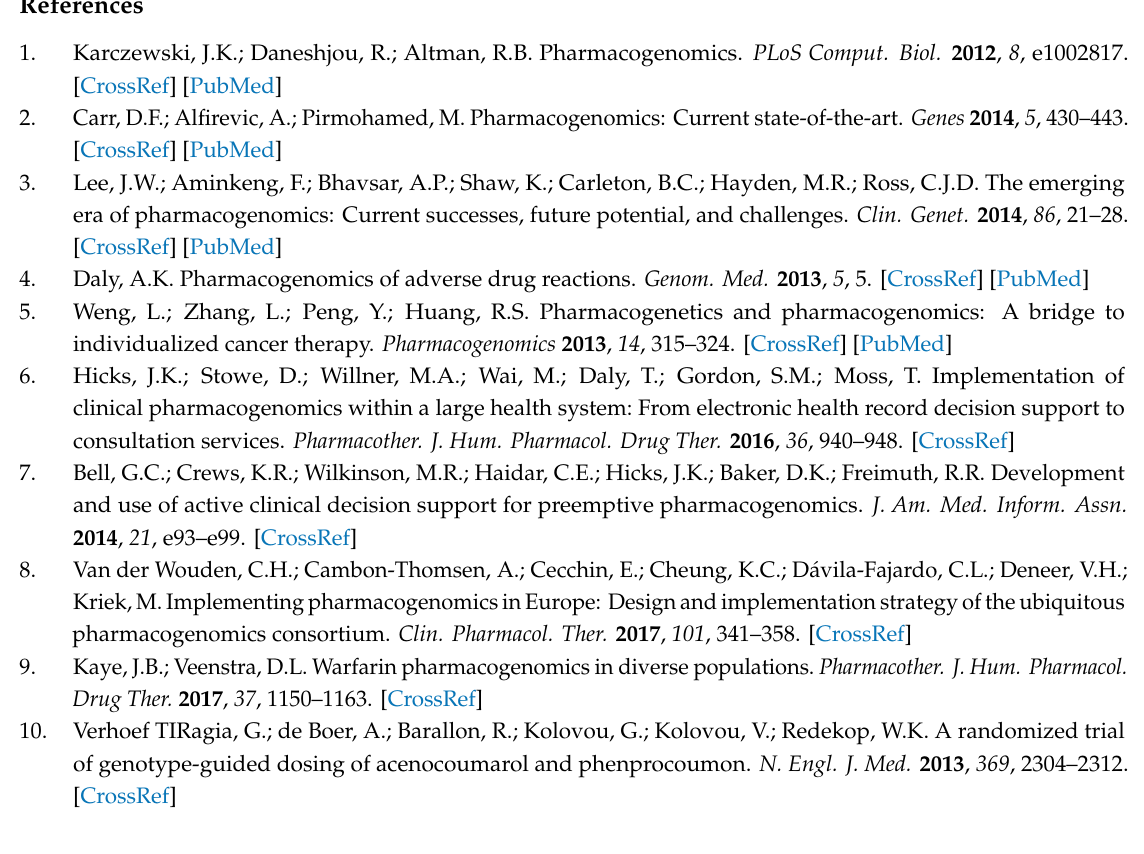
Figure S1: The number of SNPs in each biomarker that were associated with drugs in TPGxBMDL. Figure S2: The number of PubMed articles mentioning drug–biomarker pairs and ethnic group keywords in their abstracts. In total, 94 drug–biomarker pairs covered by 463 articles were obtained and only the pairs with more than 10 articles are shown here. Table S1: Ethnic group and subject information of the ALFA project. Supplementary File 1: The Microsoft Access database of PGx information related to ethnic